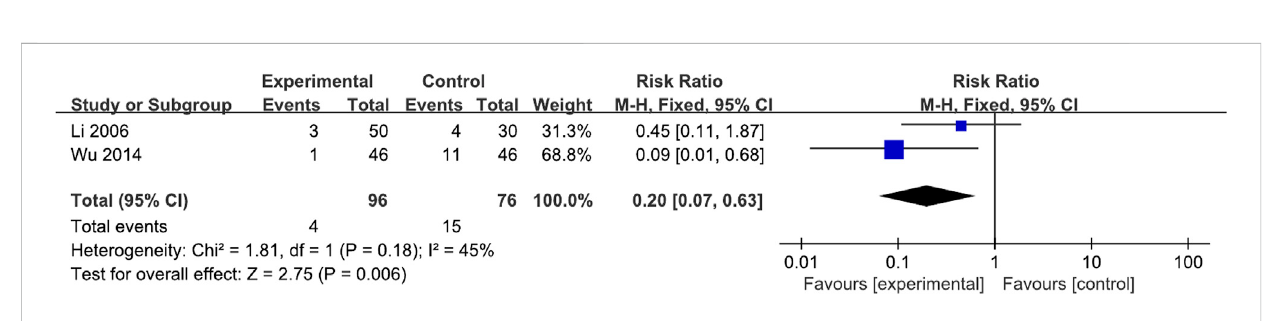
FIGURE 8 Forest plot of the comparison for the incidence of adverse events between the XYS and WM